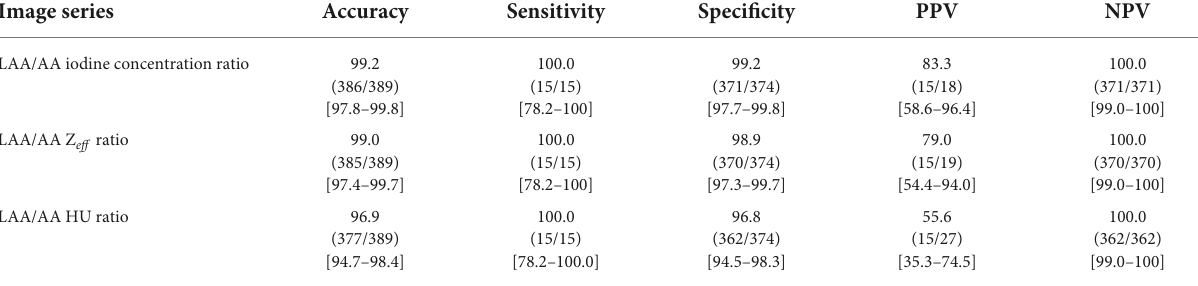
TABLE 2 Statistical results for the detection of left atrial appendage (LAA) thrombus ( n = 389). Image